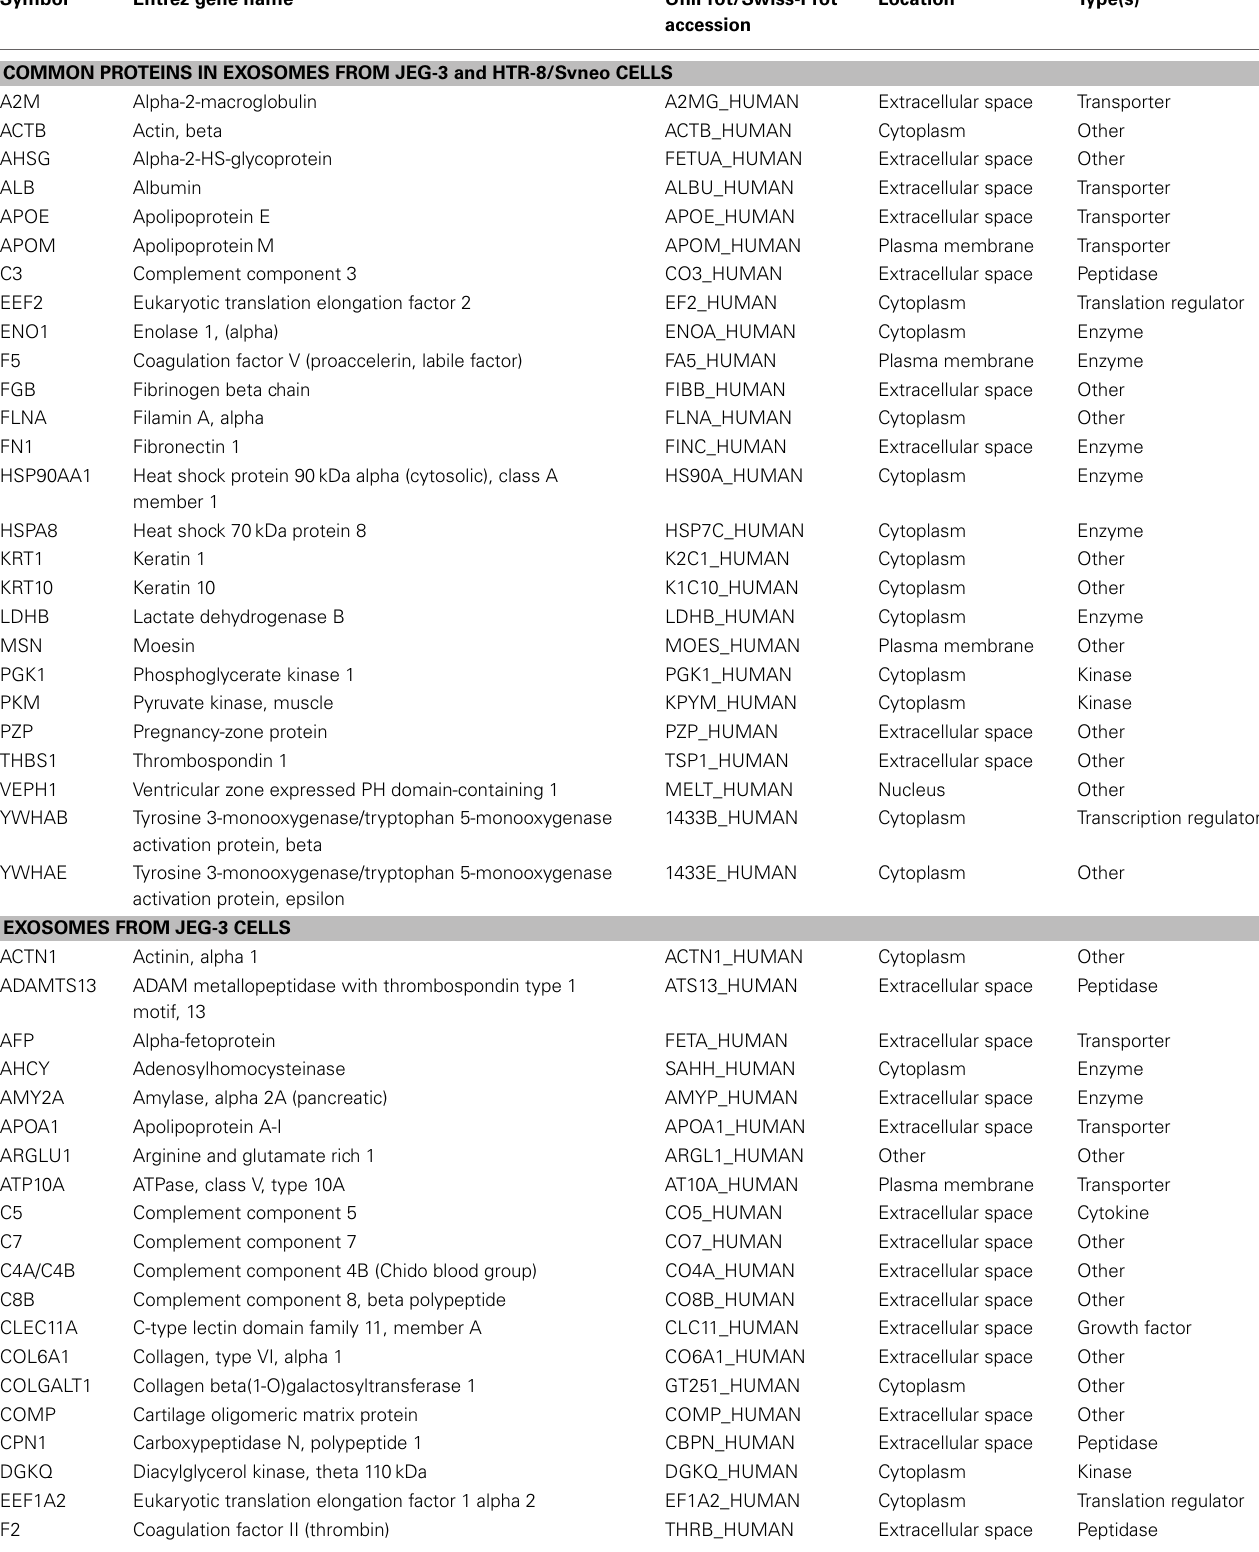
Table 2 | List of proteins identified in exosomes isolated from JEG-3 and HTR-8/SVneo cells.